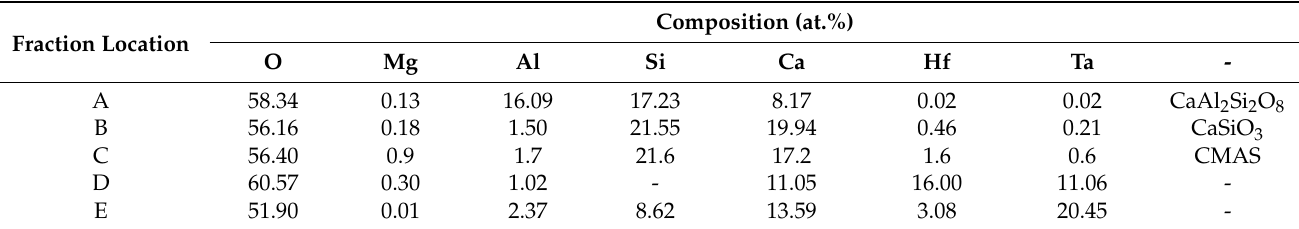
Figure 3. BSE images of the surface of Hf 6 Ta 2 O 17 ceramic after CMAS corrosion: ( a ) at 1250 °C for 8 h; ( b ) at 1300 °C for 16 h; ( c ) at 1400 °C for 16 h. The inset figures present high-magnification images of the surface. Table 1. Chemical compositions of the marked regions in Figure 3.